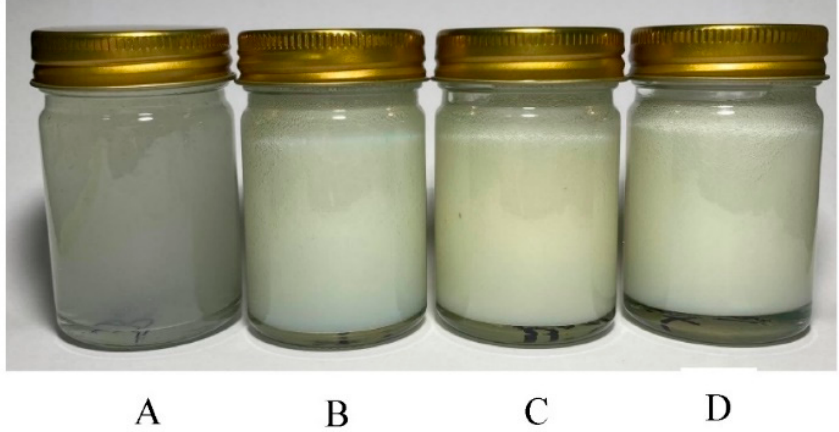
Figure 6. Appearance of ( A ) emulgel base, ( B ) emulgel containing P. frutescens seed oil microemulsion, ( C ) emulgel containing M. oleifera seed oil microemulsion, and ( D ) emulgel containing mixed seed oil microemulsion.